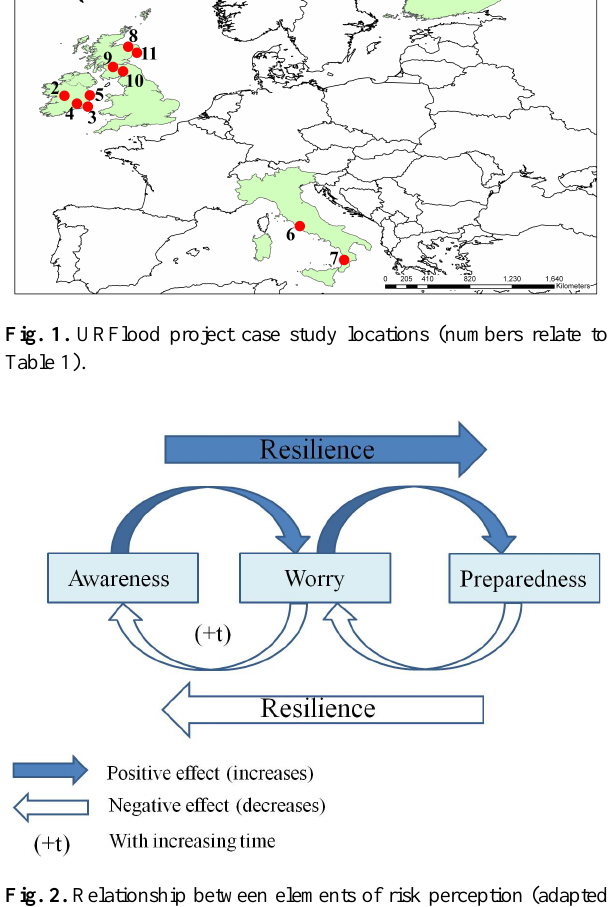
Fig. 2. Relationship between elements of risk perception (adapted from Raaijmakers et al.,